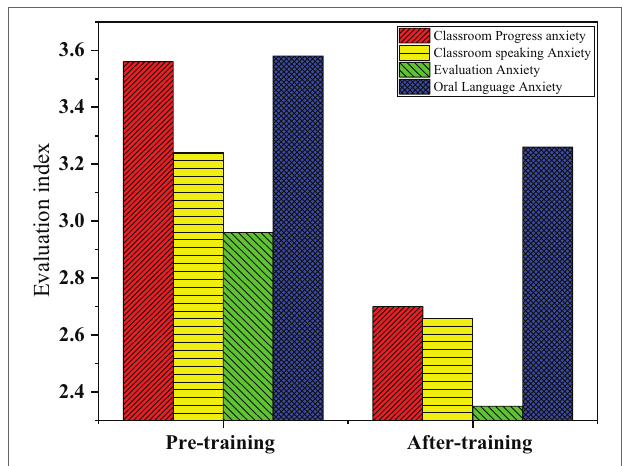
FIGURE 11 | Comparison before and after training.